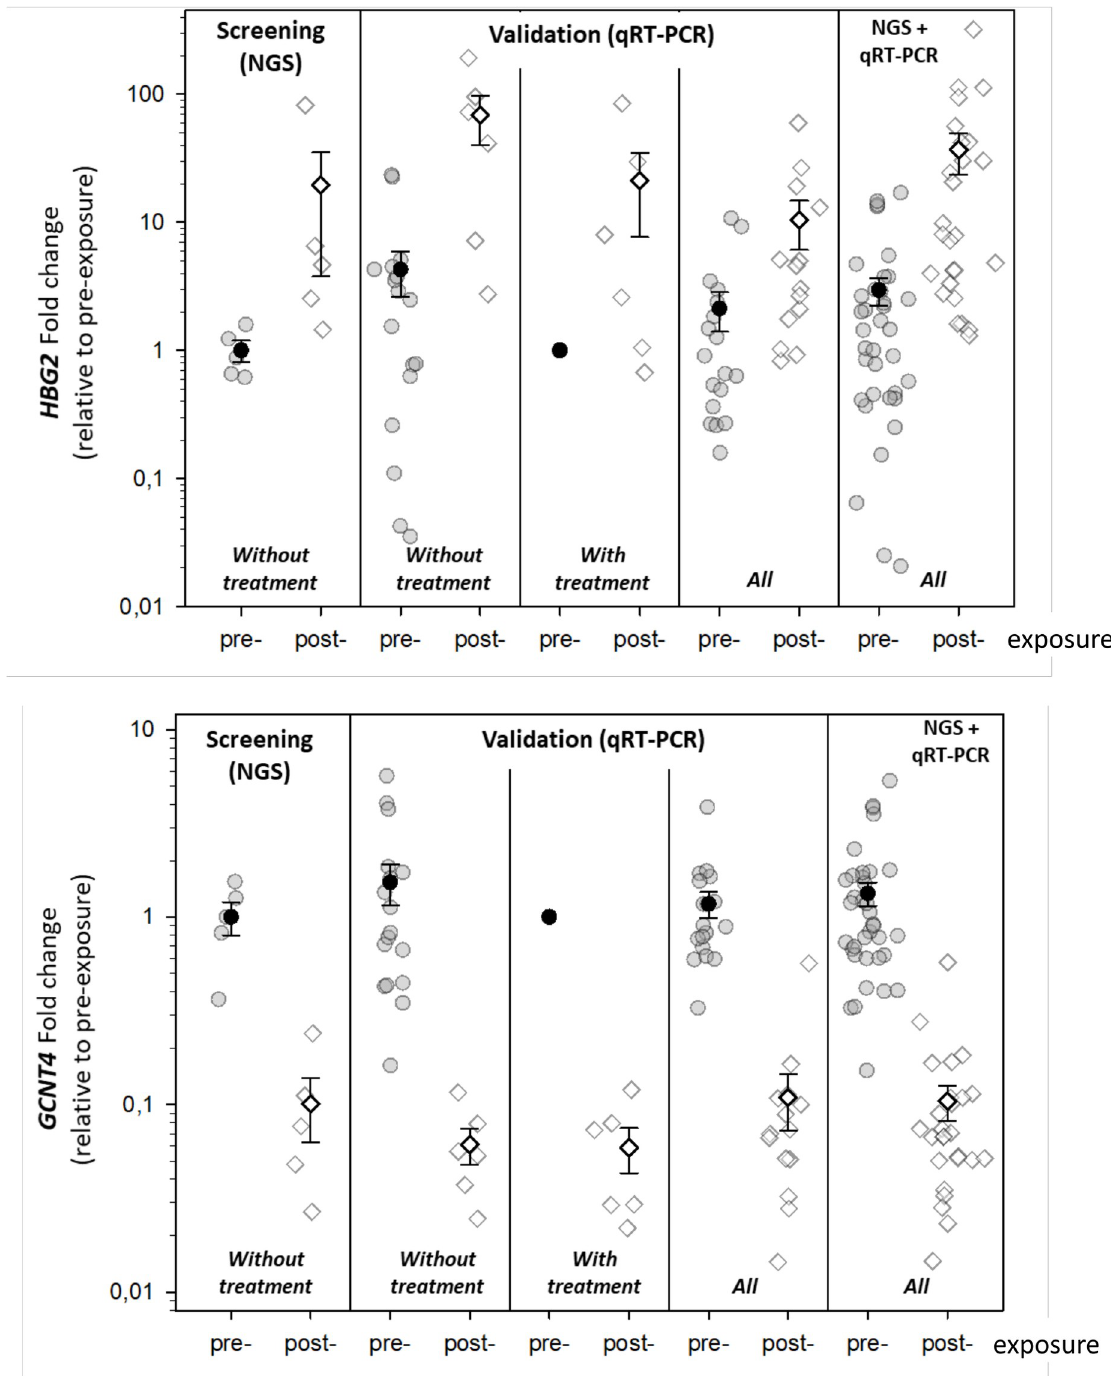
Fig 3. The jitter plots represent fold-changes in gene expression calculated between post-exposure samples relative to the pre-exposure samples, with the latter arbitrarily set to the value one. Single measurements (symbols with grey edging) as well as mean values (black edged symbols, error bars do show the standard error) of two representative genes are shown. Gene expression data from pre- and post- exposure samples used for screening (left side) or validation (right side) are shown in untreated, treated (IL12, IL12+G-CSF) and both groups combined “All”. The last plots to the right reveal gene expression measurements of all samples (screening as well as validation). Fold changes for the no treatment group were calculated based on untreated pre-exposure samples, for “all” they were calculated based on pre- exposure samples from the no treatment, IL12 and IL12+G-CSF group to ensure comparability.